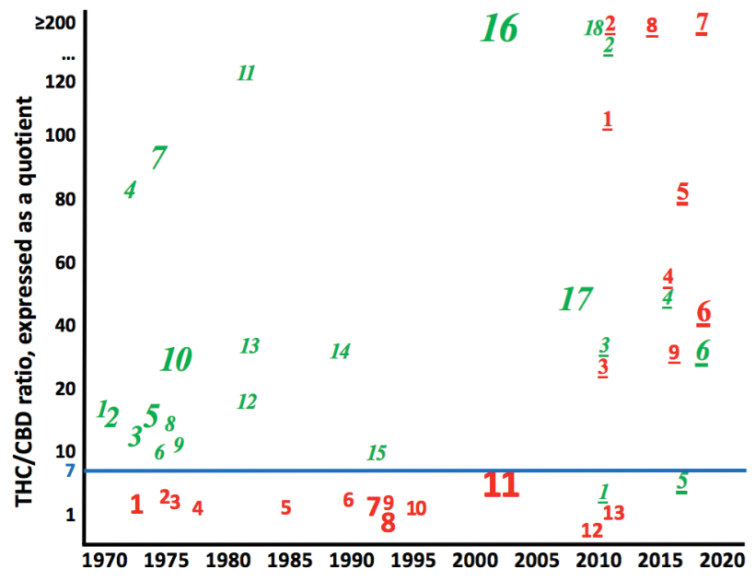
Shifts in THC/CBD ratios over time; data from 47 numbered studies in Suppl. material 1: SF.9. Central Asian landraces in unitalicized red (n =13 studies); “Indica” in underlined unitalicized red (n= 9); South Asian landraces in italicized green (n =18 studies); “Sativa” in underlined italicized green (n =7 studies). Size of numeral reflects the number of accessions analyzed in that study.